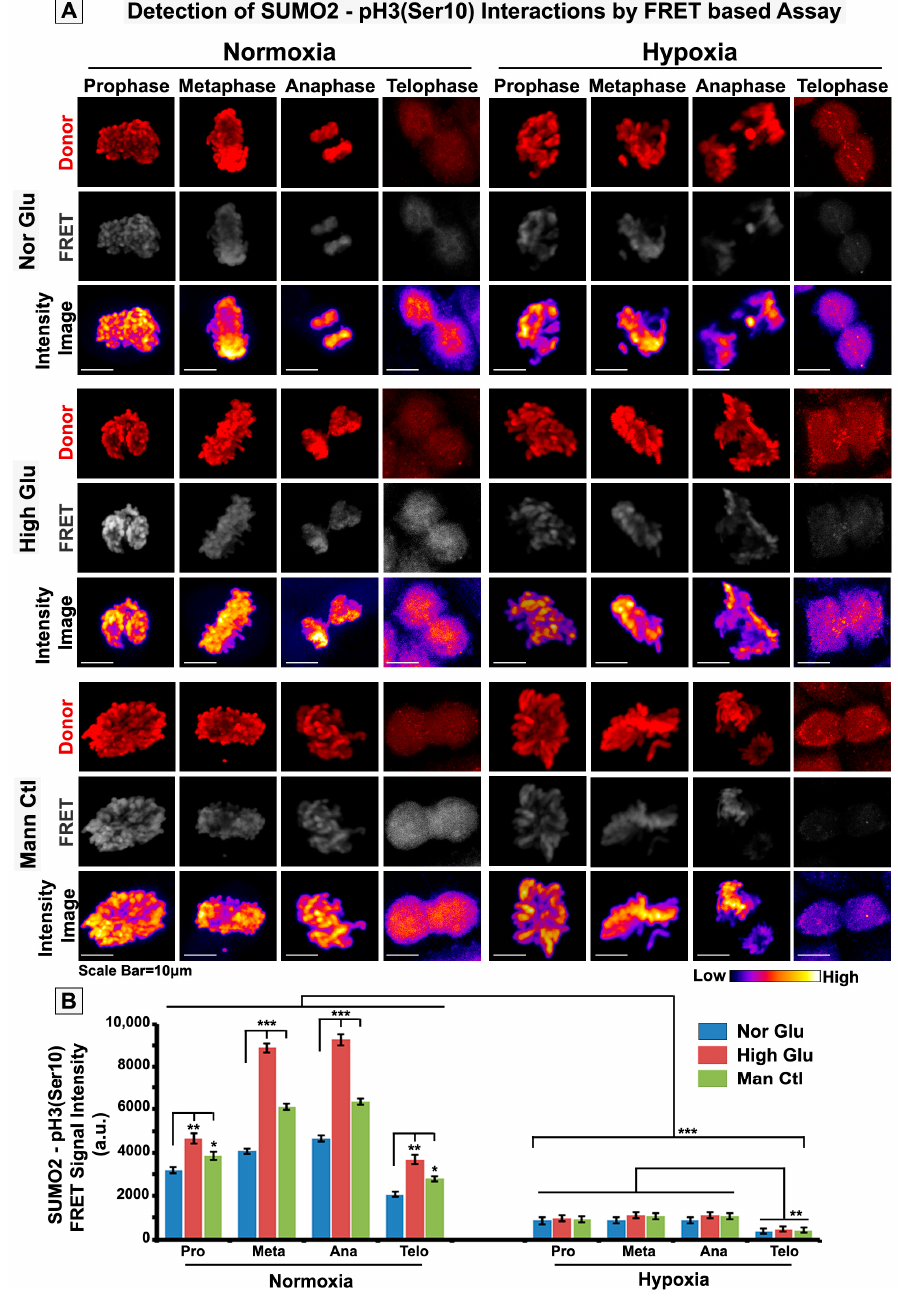
Figure 6. Direct FRET between pH3(Ser10) and SUMO2 confirms cytoplasmic sequestration of SUMOylated pH3(Ser10) in acute hypoxia exposed mitotic cells. CaSki cervical cancer cells were cultured in the general experimental set-up for 96 h. ( A , B ) Cells were immunostained with pH3(Ser10) and SUMO2 primary antibodies and were further tagged with Cy3 and Alexa flour 647 conju- gated secondary antibodies, respectively, as Cy3-Alexafluor 647 are established FRET compatible donor–acceptor pairs. Analysis showed enhanced chromosomal localization of SUMO2-pH3(Ser10) FRET signal in both HG and HG-HO conditions vs NG in normoxia. On the contrary, the FRET signal was prominent in the cytoplasm of hypoxia-treated cells. Statistical significance is represented by p values: * p ≤ 0.05, ** p ≤ 0.01 and *** p ≤ 0.001. See related Supplementary Figure S8 for correlated results in acute hypoxia-exposed non-mitotic tumour